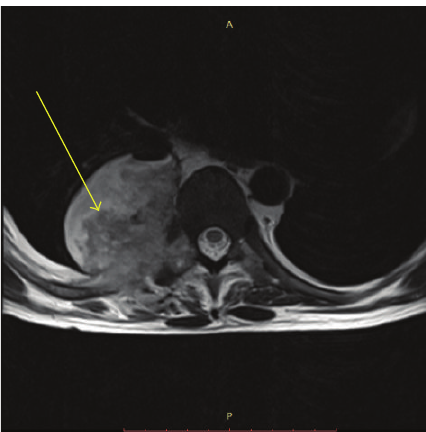
Figure 1: MRI spine (axial T1 and T2) showing paraspinal abscess on the right side with an air fluid level